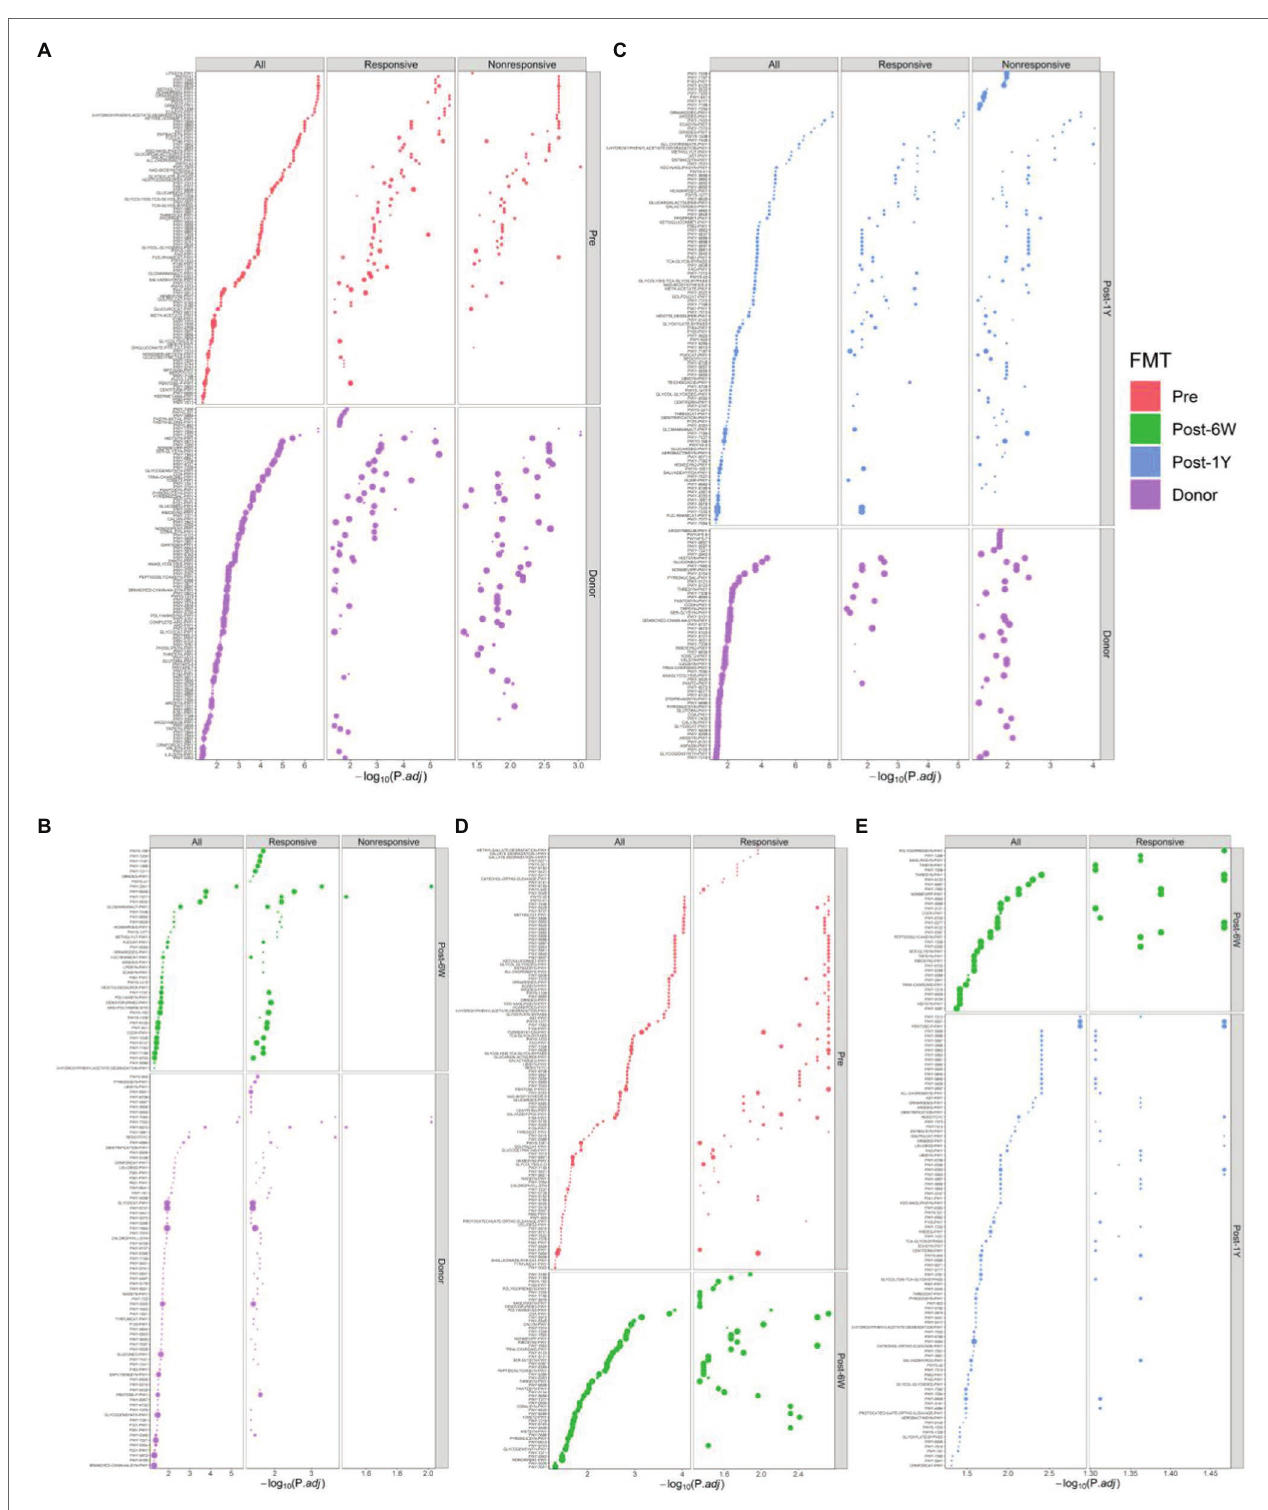
FIGURE 6 | Enriched metabolic pathways modulated in response to FMT. Comparison of differential metabolic features at different time points: between patients before FMT and donor (A) , patients 6 weeks after FMT and donor (B) , patients 1 year after FMT and donor (C) , patients before FMT and 6 weeks after FMT (D) , and patients 6 weeks after FMT and 1 year after FMT (E) . The size of each point indicates the average relative abundance of this metabolic